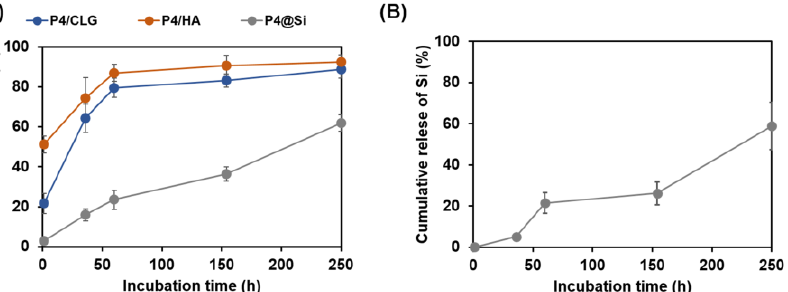
Figure 3. Time-dependent peptide and silica release from P4/silica hybrids. ( A ) Comparison of the cumulative release of P4 over 250 h from the delivery systems; ( B ) cumulative silica release from P4@Si over 250